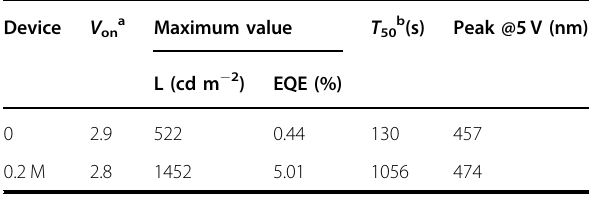
Table 1 Summary of EL performance of the pristine and FA cation doped blue QD